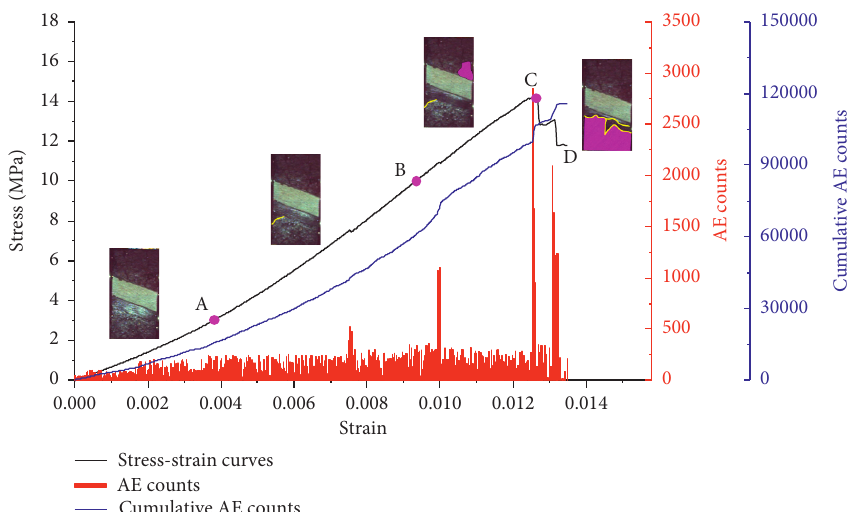
Figure 4: Stress-strain curve and acoustic emission monitoring curve of composite specimens with a 10 ° dip angle (A10-1).